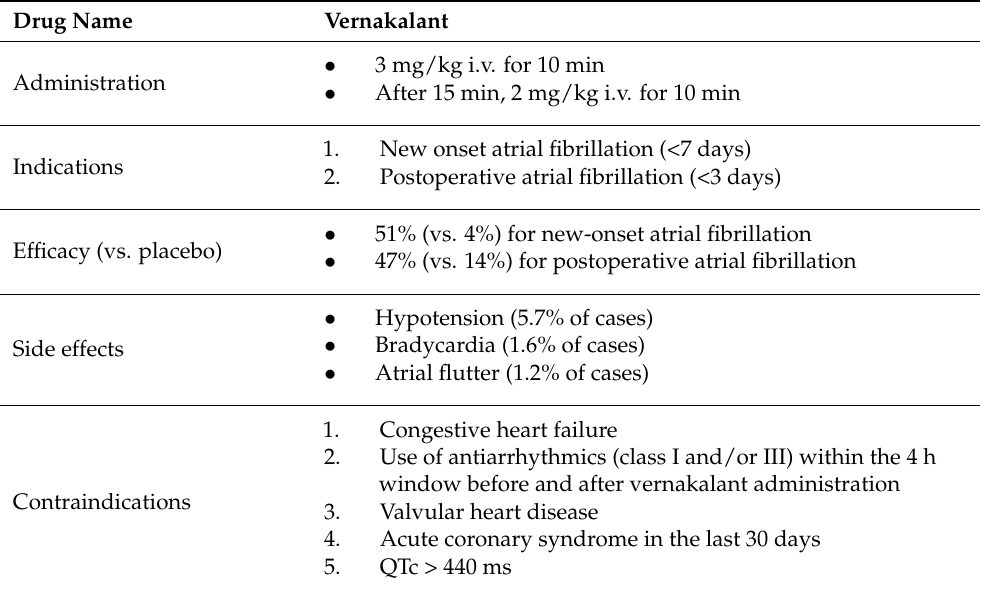
Table 2. Summary of vernakalant properties (based on information provided by the European Medicines Agency) [18].